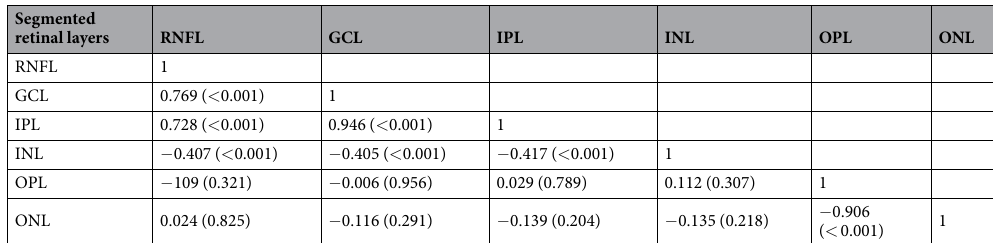
Table 4. Pearson correlation coefficient on segmented retinal layer thicknesses in the macular region of glaucoma patients. RNFL = retinal nerve fiber layer; GCL = ganglion cell layer; IPL = inner plexiform layer; INL = inner nuclear layer; OPL = outer plexiform layer; ONL = outer nuclear